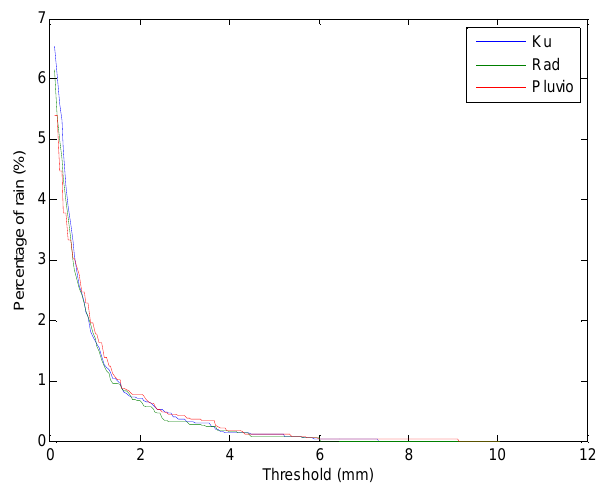
Fig. 9. Examples of time series recorded by the Ku device (red curve) and the radar (blue curve) .